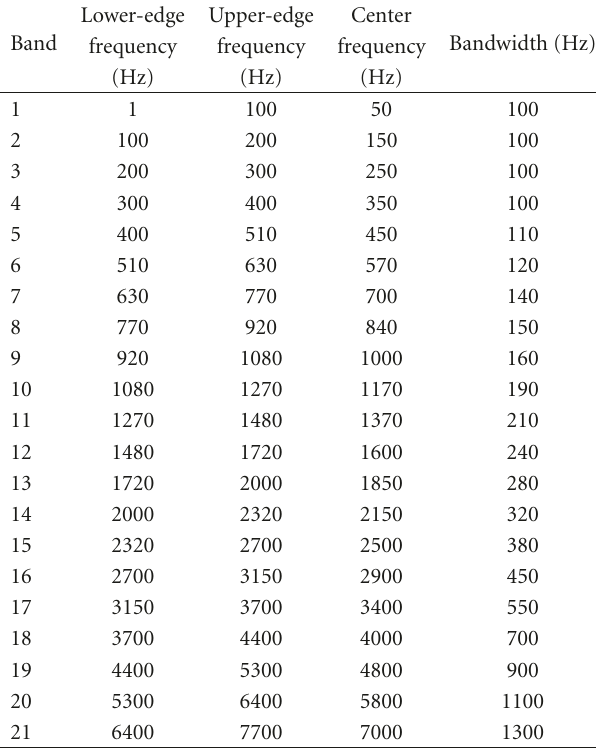
Table 2: Upper-edge frequencies, lower-edge frequencies, cen- ter frequencies, and bandwidths for 21-channel filter-bank with critical-band spacing